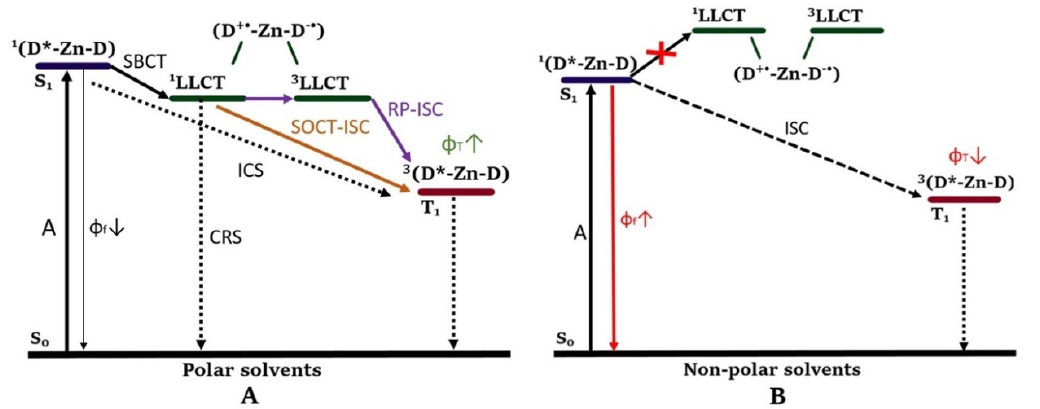
Figure 17. Simplified energy diagram showing the excited-state decay pathways in polar solvents ( A ) and non-polar solvents ( B ). The energy of the (non-emissive) LLCT states is dependent on the solvent. Adapted from [168].